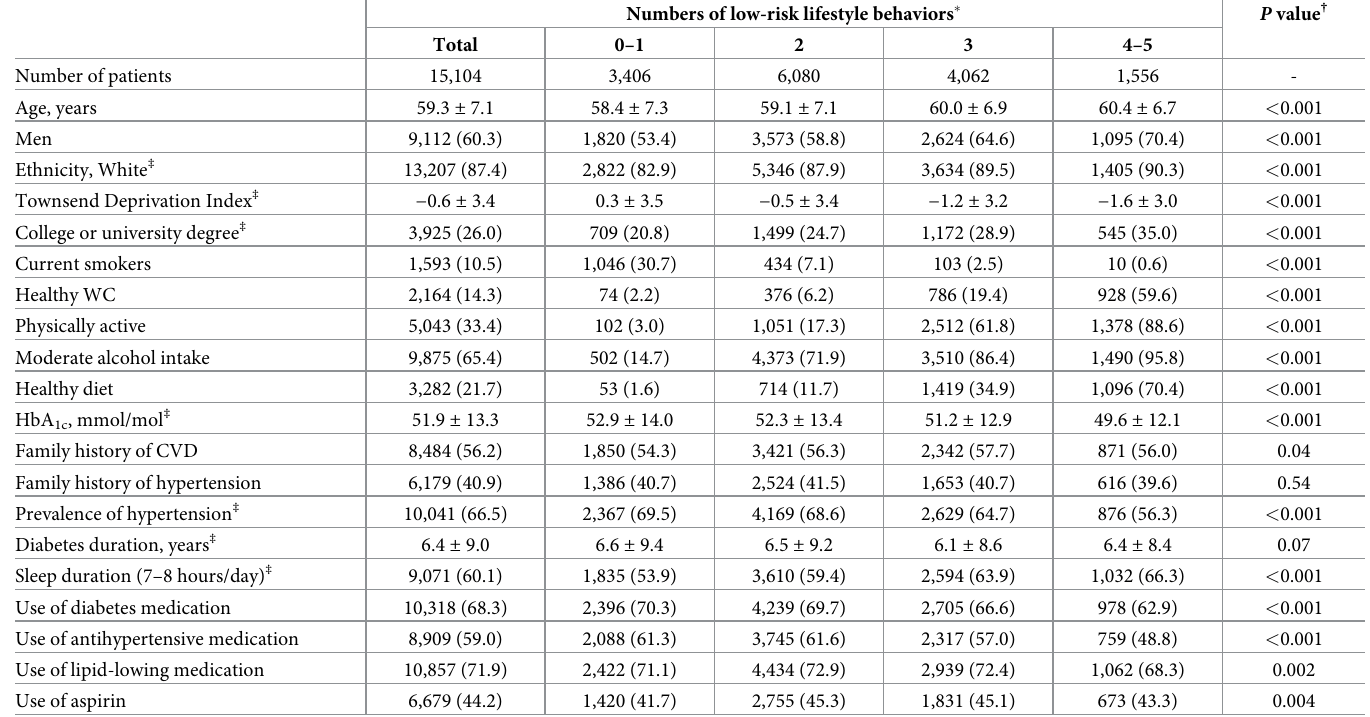
Table 1. Baseline characteristics of the study population according to numbers of low-risk lifestyle